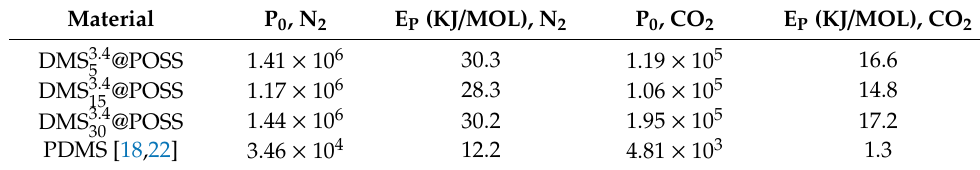
Figure 8. ( a ) Arrhenius plot for three DMS 3.4 y @POSS membranes with di ff erent crosslinking ratio (permeability dependence on temperature); (b) selectivity dependence on temperature. Table 4. Permeation parameters for nitrogen (N 2 ) and carbon dioxide (CO 2 ) of DMS 3.4 y @POSS membranes with di ff erent crosslinking ratio derived from the Arrhenius plot in Figure 8. Data compared to PDMS reported in literature [22].